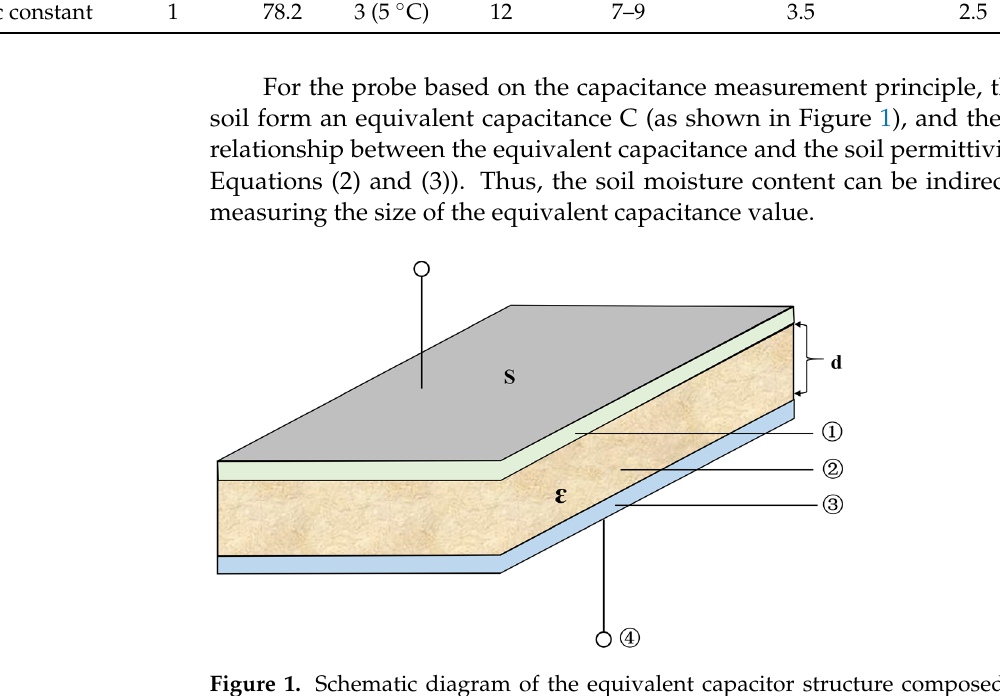
Figure 1. Schematic diagram of the equivalent capacitor structure composed of soil and probe. ① Upper plate; ② soil; ③ lower plate; ④ leads.